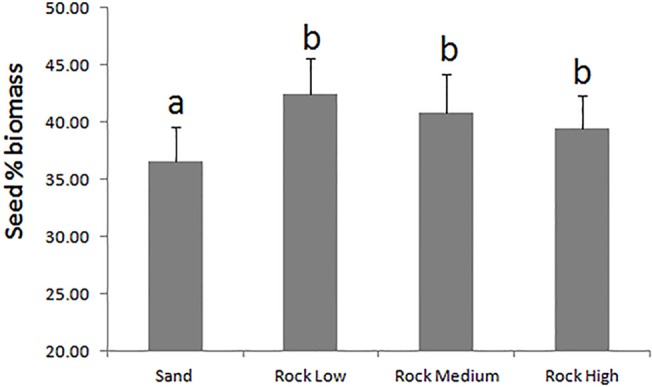
Effect of the Substrate on the seed % biomass in P. oceanica seedlings.Letters above standard error bars indicate significant differences between treatment levels.